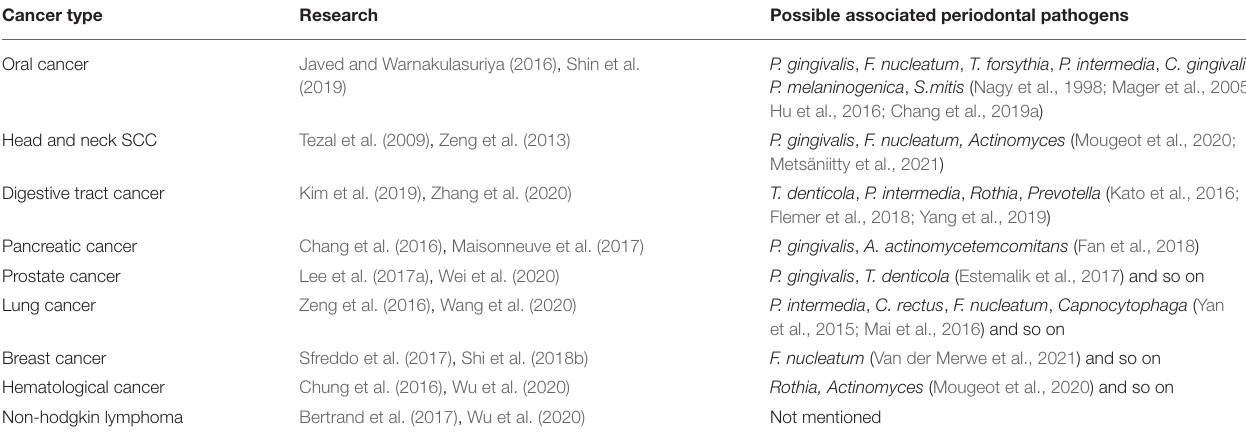
TABLE 1 | List of different types of cancer associated with periodontitis and possible associated periodontal pathogens. Cancer